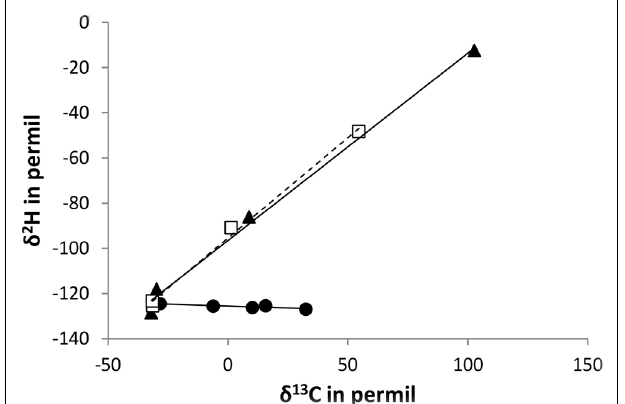
FIGURE 4 | Changes in carbon and hydrogen isotope ratios for degradation of chloromethane by L. methylohalidivorans MB2 ((cid:129)), M. extorquens CM4 ( (cid:2)(cid:2)(cid:2) ), and Hyphomicrobium sp. MC1 ( (cid:3) ) at different time points during growth (increase in time from left to right of the graph). Lines (slope = − 0.03 ( R 2 : 0.8014) for strain MB2, slope = 0.89 ( R 2 : 0.9954) for strain CM4, and slope = 0.83 ( R 2 : 0.9939) for strain MC1, respectively) represent best fit